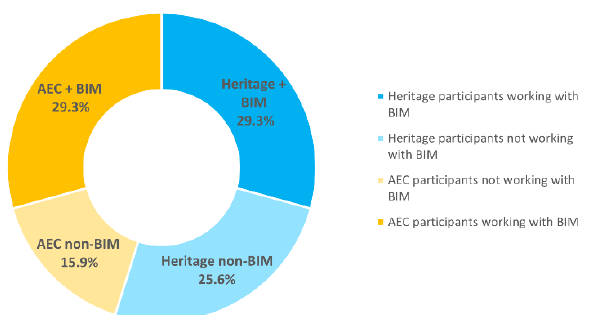
Figure 5: Distribution of participants by heritage/AEC and the usage or not of BIM.